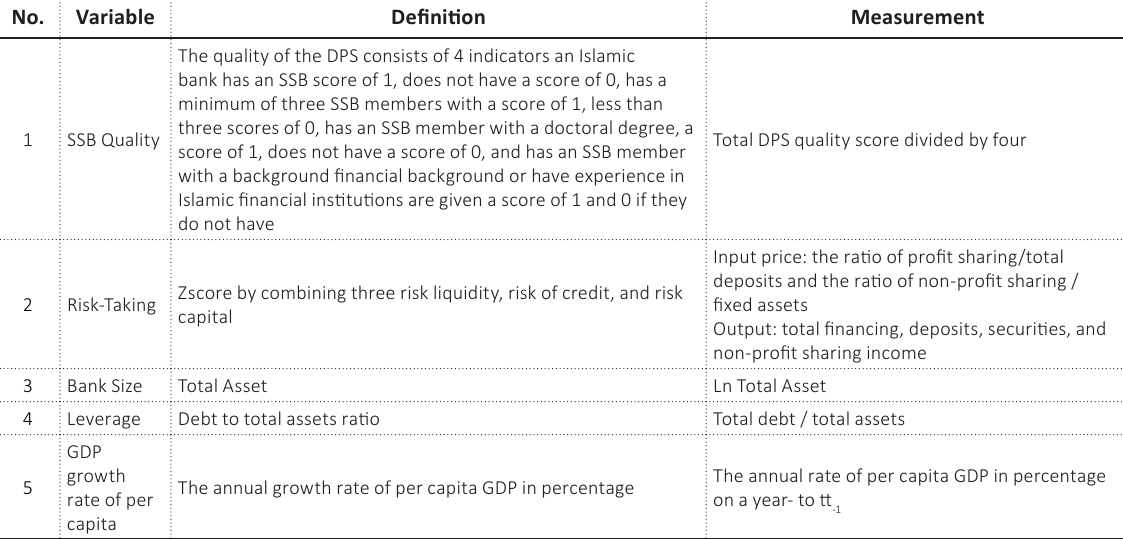
Table 3. Measurement of independent